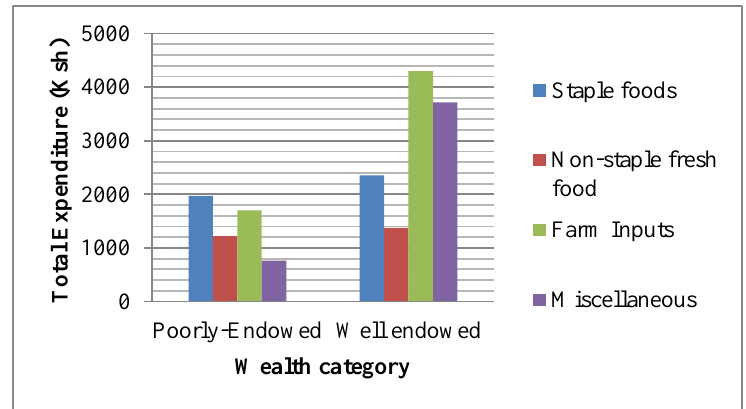
Figure 3. Household Expenditure Profile. Source: Authors’ survey, 2017.